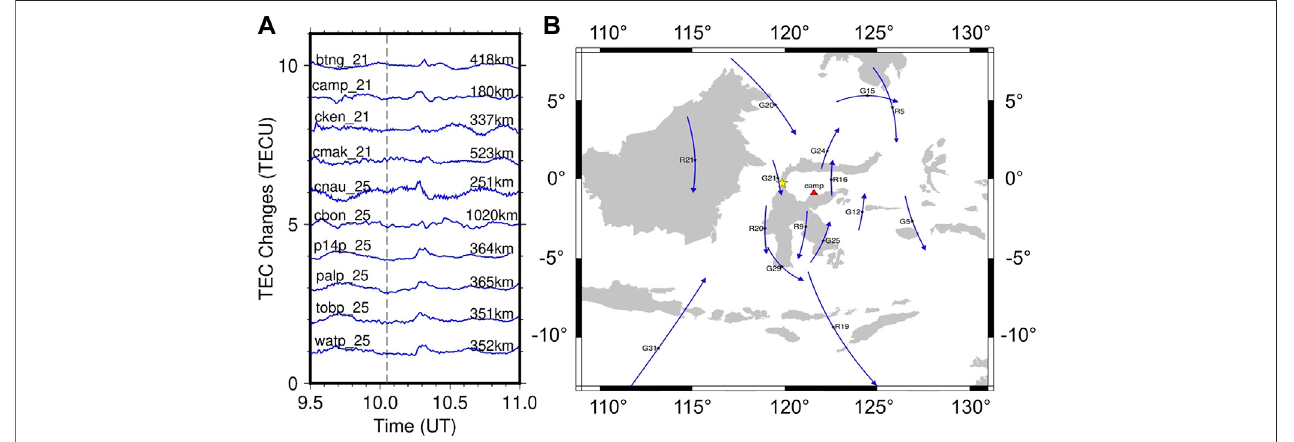
FIGURE 2 | (A) Time series changes in TEC for the 2018 Palu Earthquake at 9.5 – 11 UT by GPS atellite 21 and 25. (B) Trajectories of SIP during the 2018 Palu Earthquake and a large yellow star indicate the epicenter ’ s